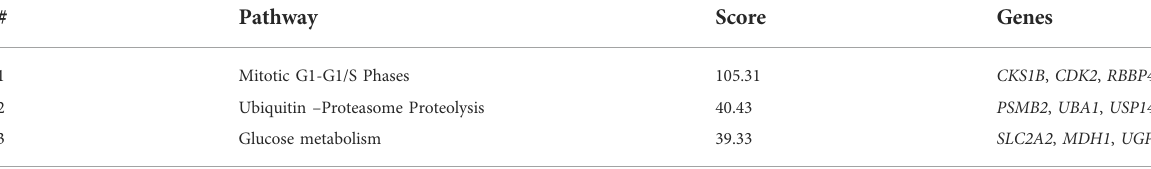
TABLE 6 Gene Analytics top enriched pathways in gne KO versus gne WT zebra fi sh at 7 dpf.